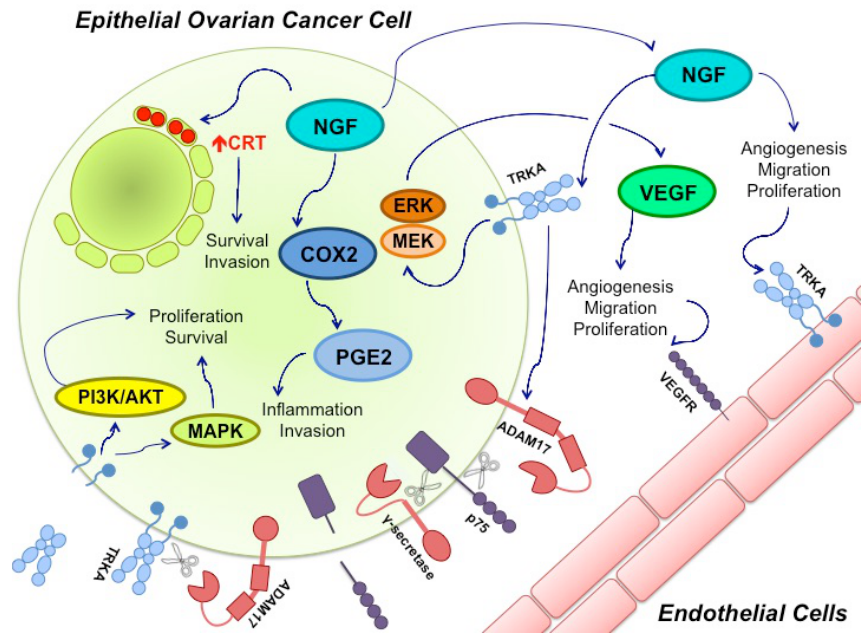
Figure 1. Nerve growth factor (NGF) and its Tyrosine Kinase A receptor (TRKA) are involved in several signaling pathways in epithelial ovarian cancer (EOC). Ovarian cancer cells express and secrete NGF. Through TRKA activation, NGF induces angiogenesis by directly stimulating endothelial cell proliferation and migration. NGF also regulates angiogenesis in an indirect manner through vascular endothelial growth factor (VEGF) production by epithelial cancer cells. This mechanism involves TRKA activation and the Mitogen-activated protein kinase/Extracellular signal-regulated kinase (MEK/ERK) signaling pathway. Besides, NGF increases ciclooxigenase-2 (COX-2) levels, a proinflamatory molecule that induces protaglandine-2 (PGE-2) production; COX-2 and PGE-2 have been associated with invasion in cancer cells. NGF can also increase calreticulin (CRT) levels (Red Arrow), an endoplasmic reticulum resident whose levels have been found to be elevated in